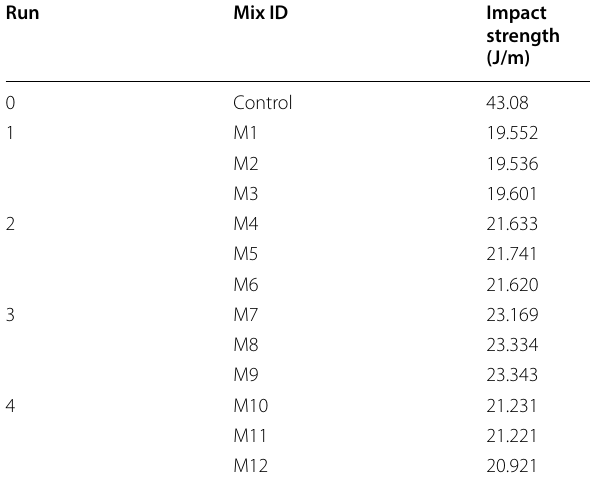
Table 7 Impact strength results